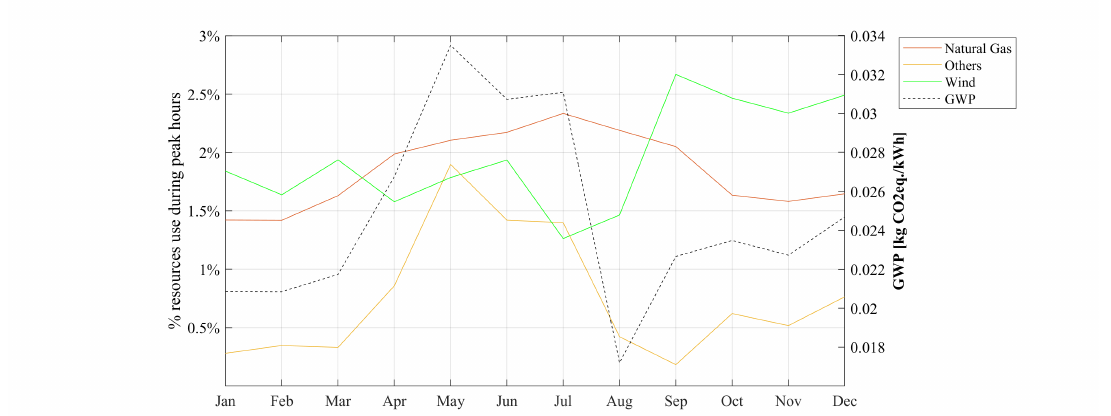
Figure 10. Percentage use of resources throughout the year compared with monthly GWP in Norway, both related to peak